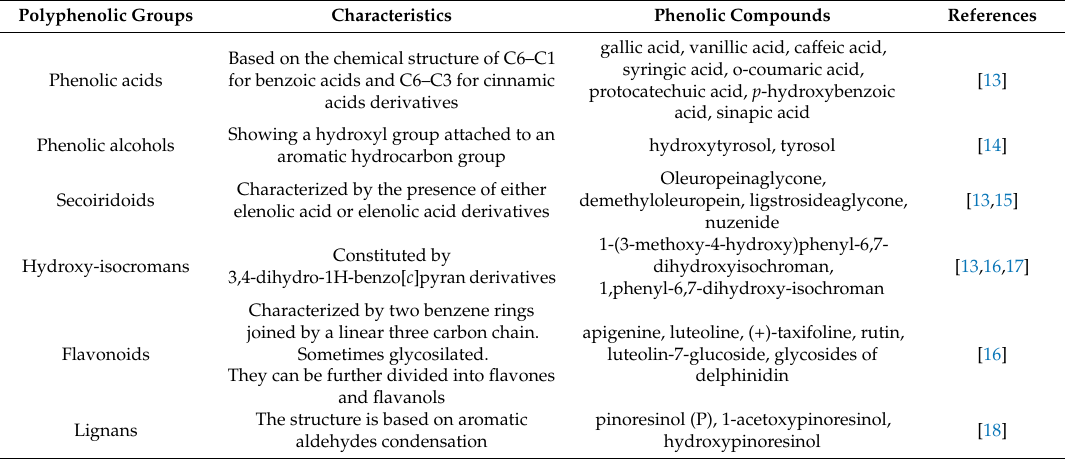
Table 1. Main phenolic groups and phenolic compounds identified in extra virgin olive oil (EVOO).